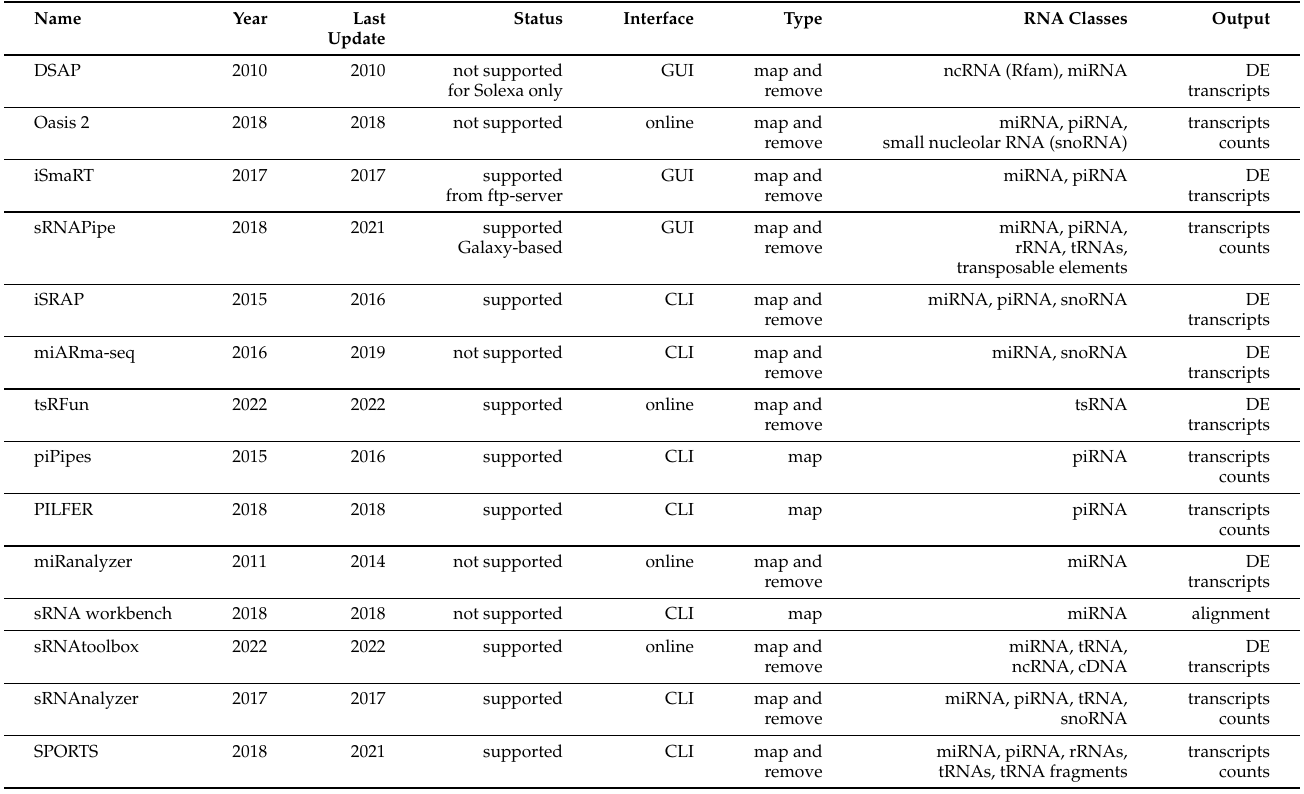
Table 1. Main features of some existing sRNAs